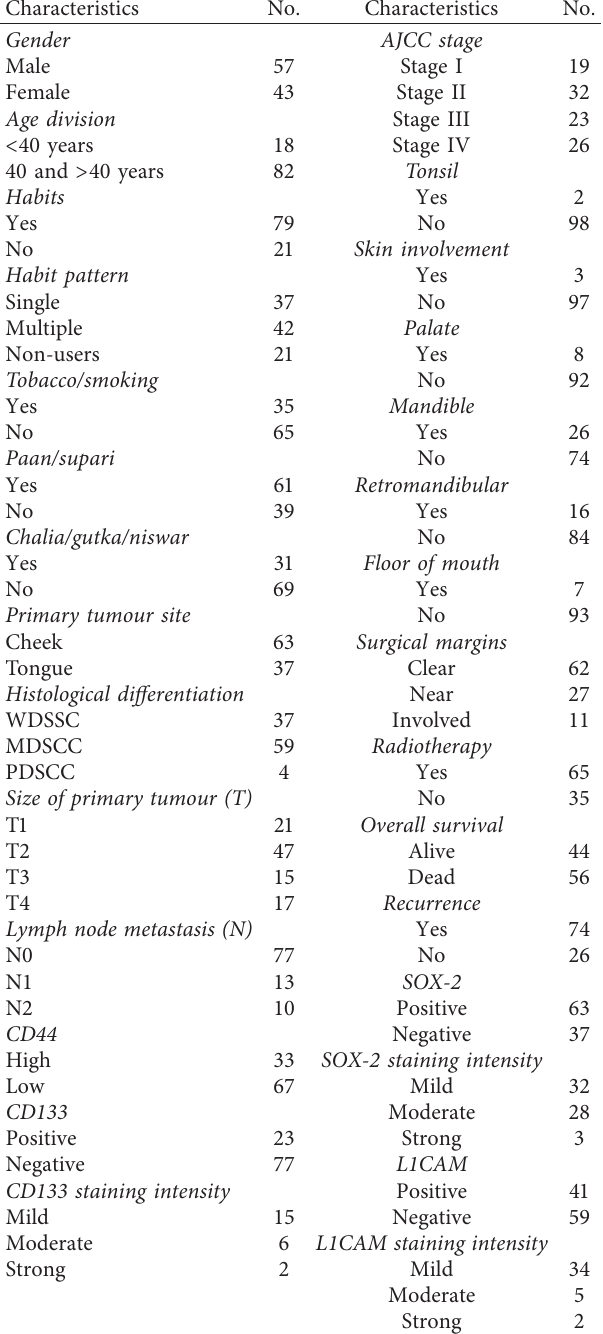
Table 3: Patient characteristics ( n � 100).